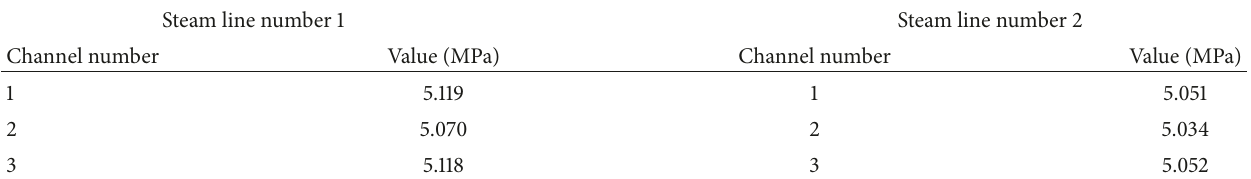
Table 4: TRACE calculated minimum values of low pressure compensated signals for both steam lines at around 10s.